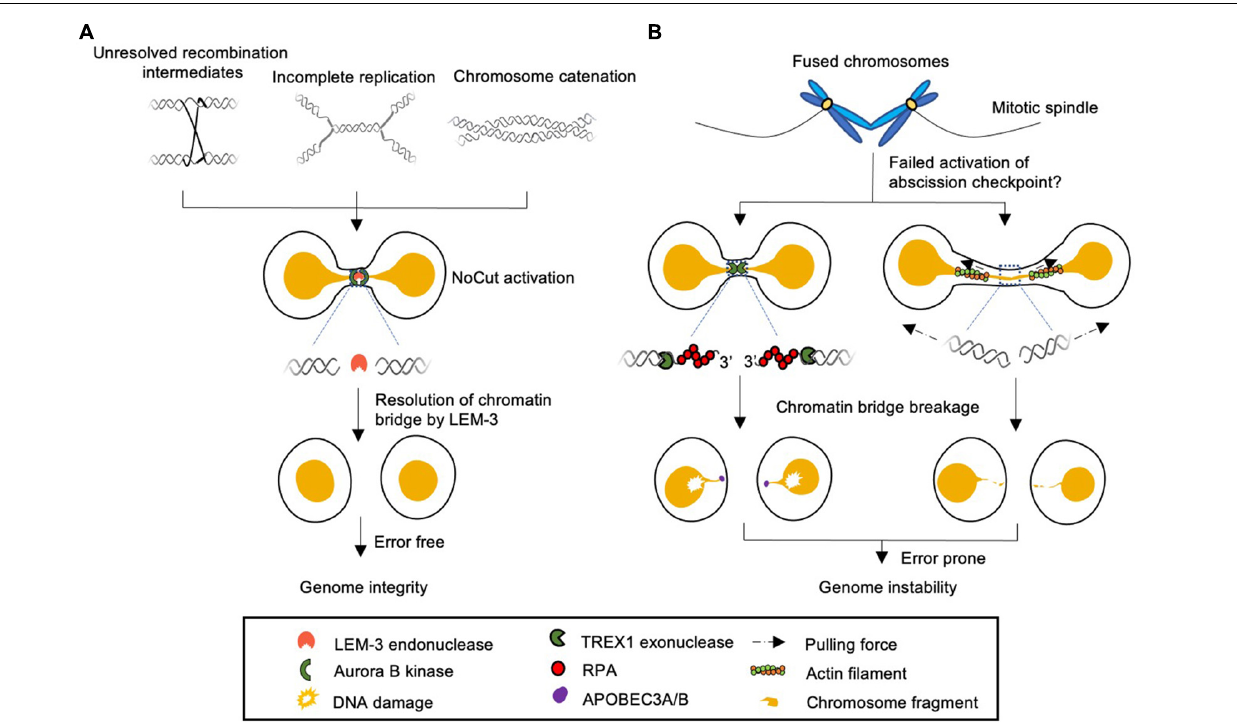
FIGURE 1 | Model of different cellular responses to chromatin bridges during cell division. (A) Chromatin bridges arise from incomplete DNA replication, unresolved recombination intermediates, and DNA catenation can be detected by Aurora B kinase dependent NoCut checkpoint. The NoCut checkpoint delays abscission, which allows time for subsequent chromatin bridge resolution. In C. elegans chromatin bridges are resolved by the midbody-tethered LEM-3 endonuclease. LEM-3 is likely to be error-free and acts as “a last chance saloon” to protect against the severing of chromosomes and associated genome instability just before cell division is completed. It remains to be elucidated if LEM-3 and its mammalian homolog ANKLE1 are regulated by the NoCut checkpoint pathway. (B) Chromatin bridges that fail to trigger the NoCut checkpoint in yeast can be severed by a process that involves the TREX1 exonuclease and APOBEC3A/B deaminases in human cells (left panel). Severing can also occur by actomyosin dependent mechanical force (right panel). These pathways are highly toxic and frequently lead to aberrant chromosomal rearrangements and the formation of